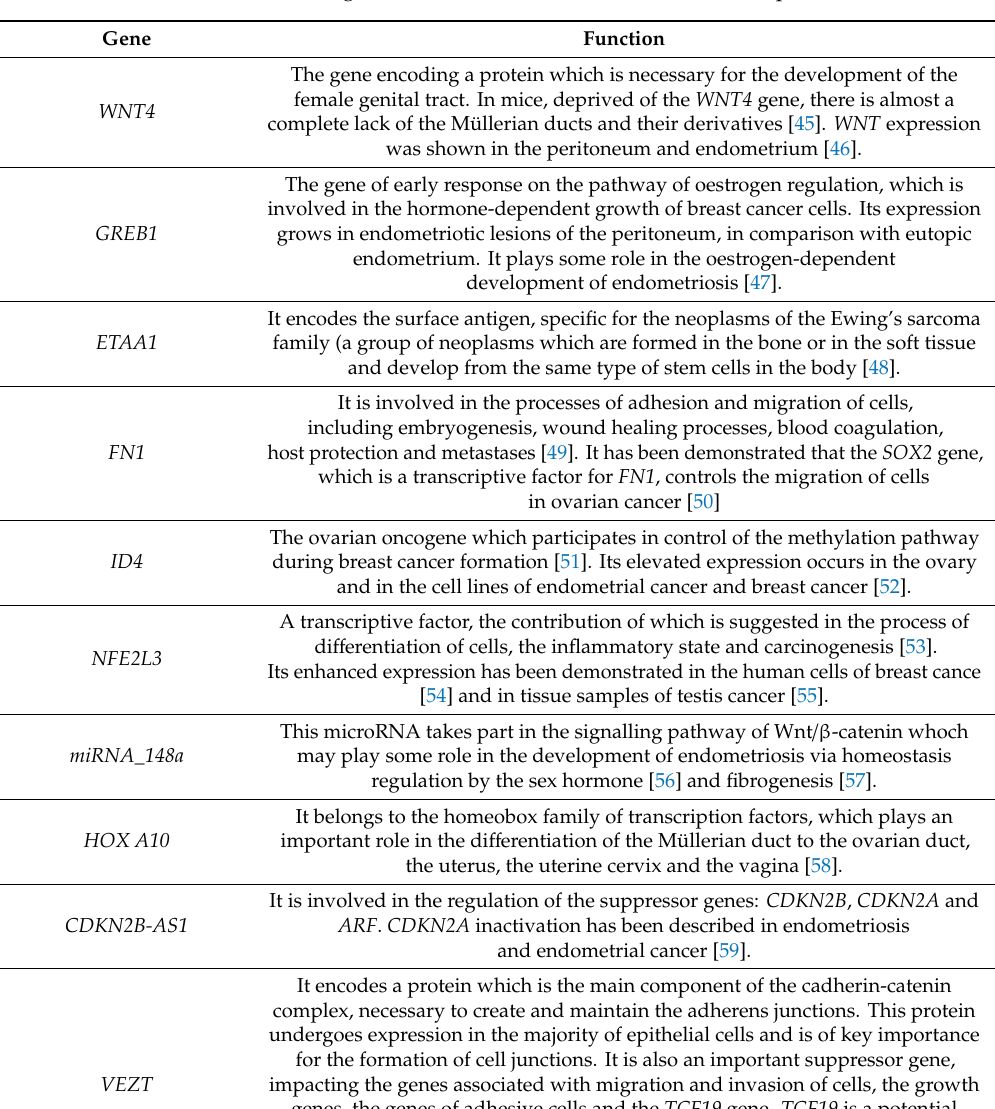
Table 3. Candidate genes associated with endometriosis